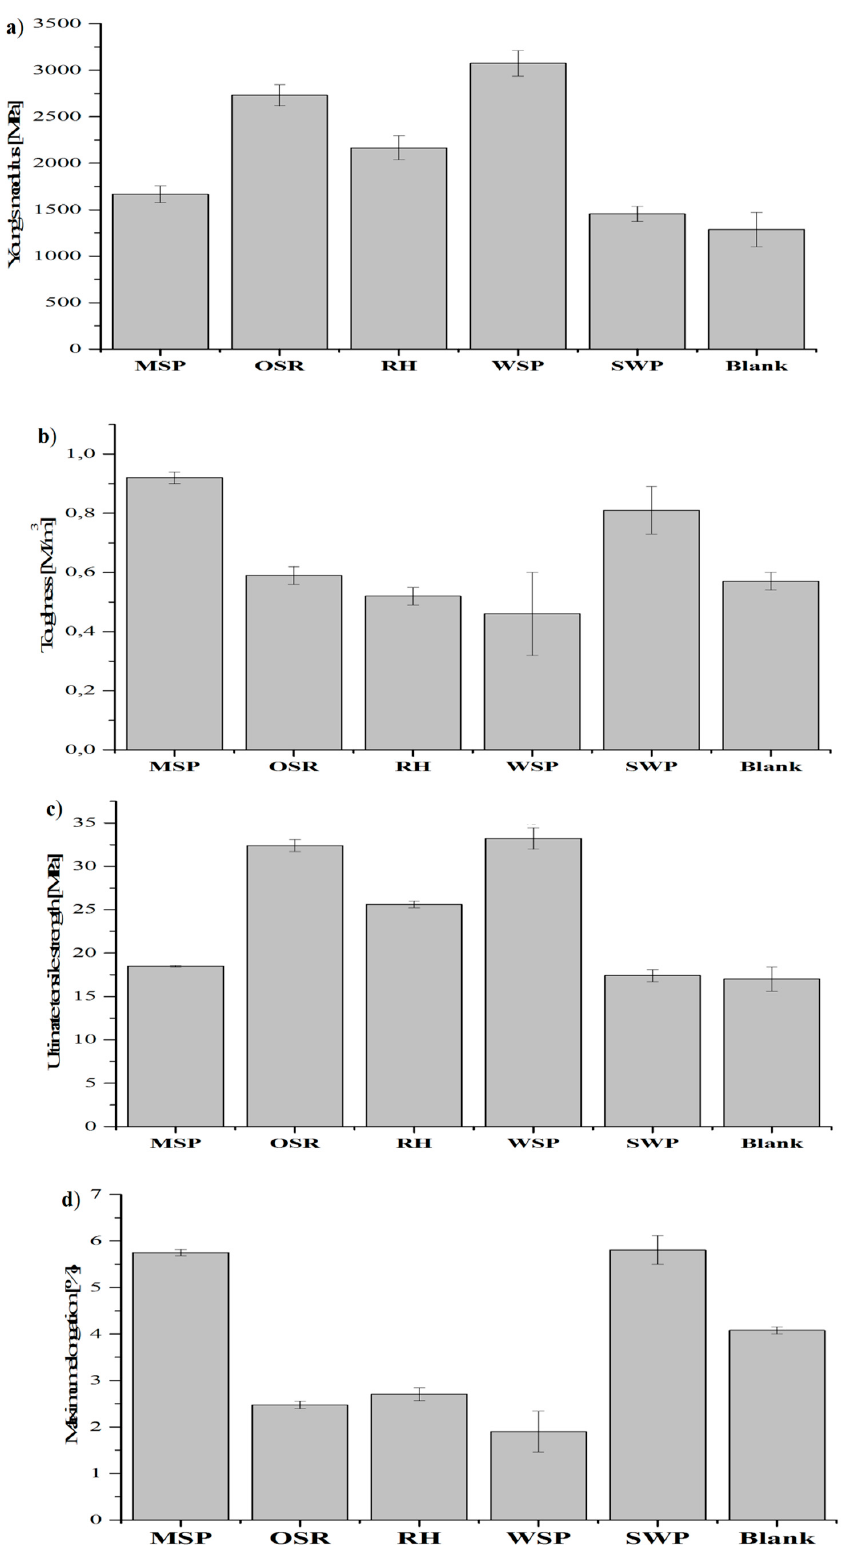
Figure 7. ( a ) Young’s modulus, ( b ) toughness, ( c ) ultimate tensile strength, and ( d ) maximum elongation of biochar containing composites and neat resin. Data were reported as average values of at least three runs.